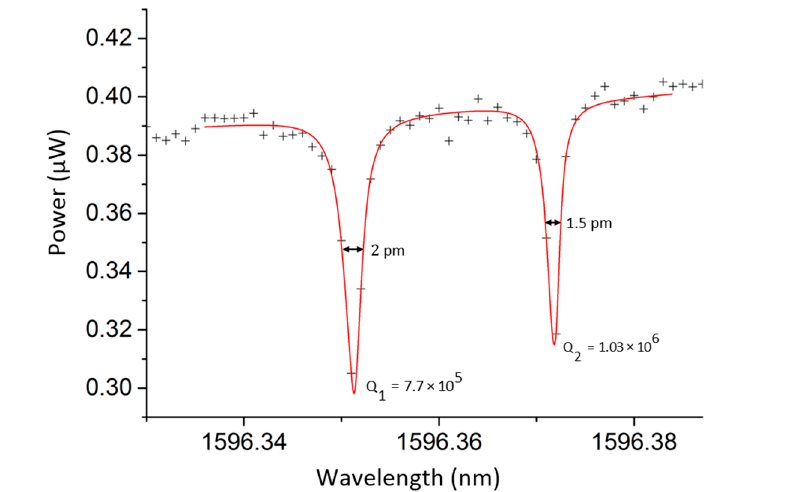
Figure 4. Narrowband transmission spectrum of an 8 µm radius disk with high loaded optical quality factor WGM